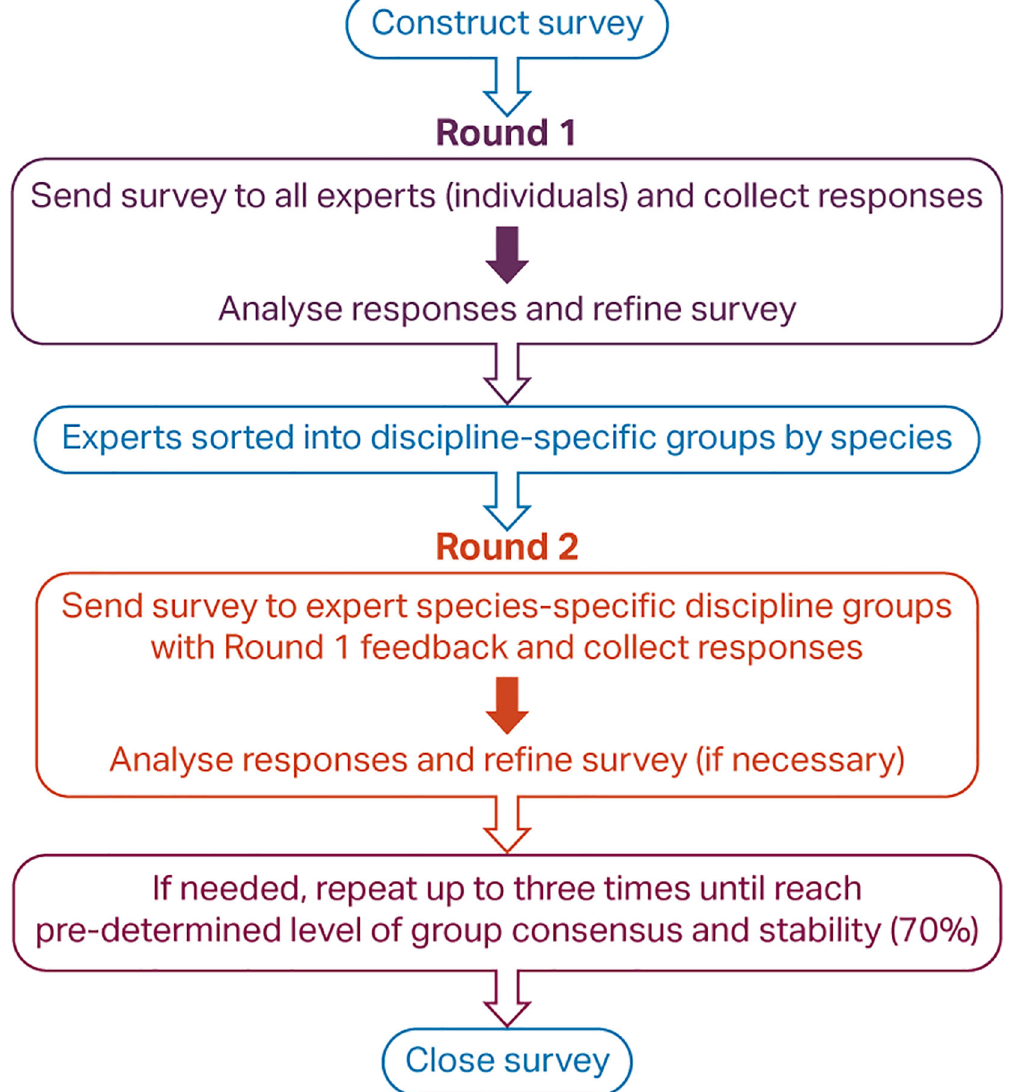
Figure 2. Steps in a hybridised Delphi